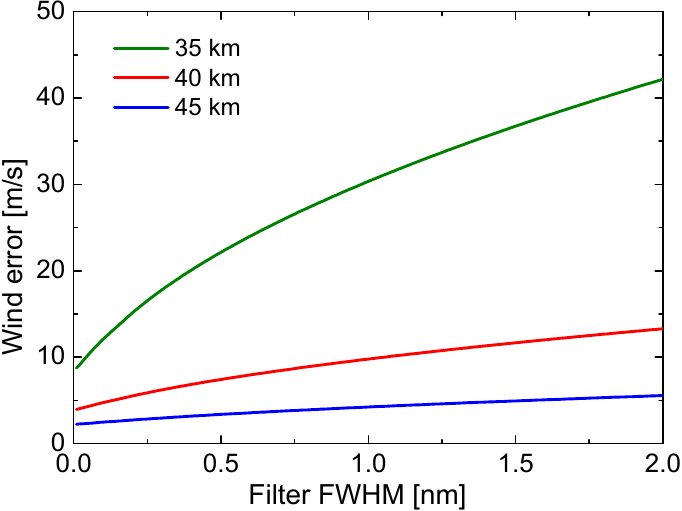
Figure 14. The wind errors as a function of filter FWHM for different tangent heights.